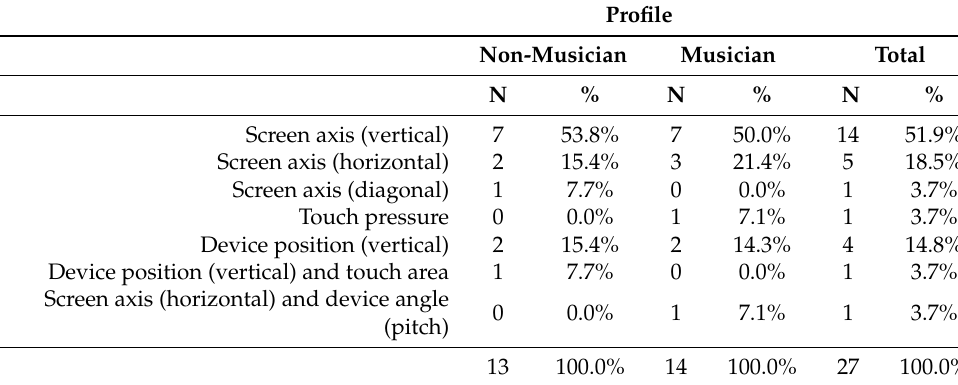
Table A10. Pitch variation mapping (uncategorized)—stimulus a.